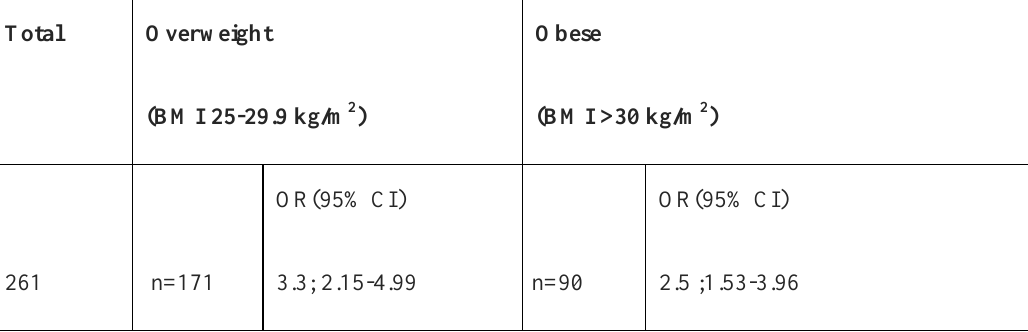
Table 2: Unadjusted OR for selected age ( ≥ 30) by BMI